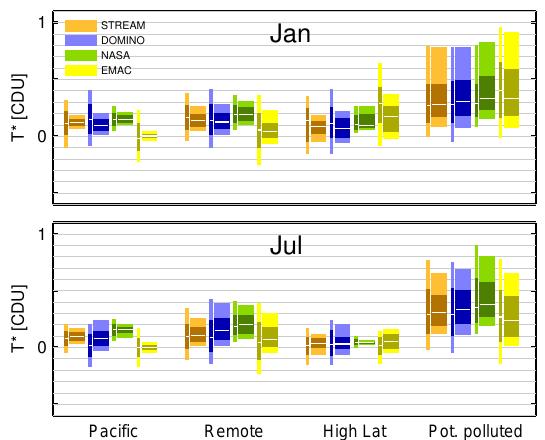
Figure 8. Regional statistics of OMI tropospheric residues T ∗ from different STS algorithms for January (top) and July (bottom) 2005. Note that the values for STREAM slightly differ from Fig. 6, as here only coincident satellite pixels of STREAM, DOMINO, and NASA are included.